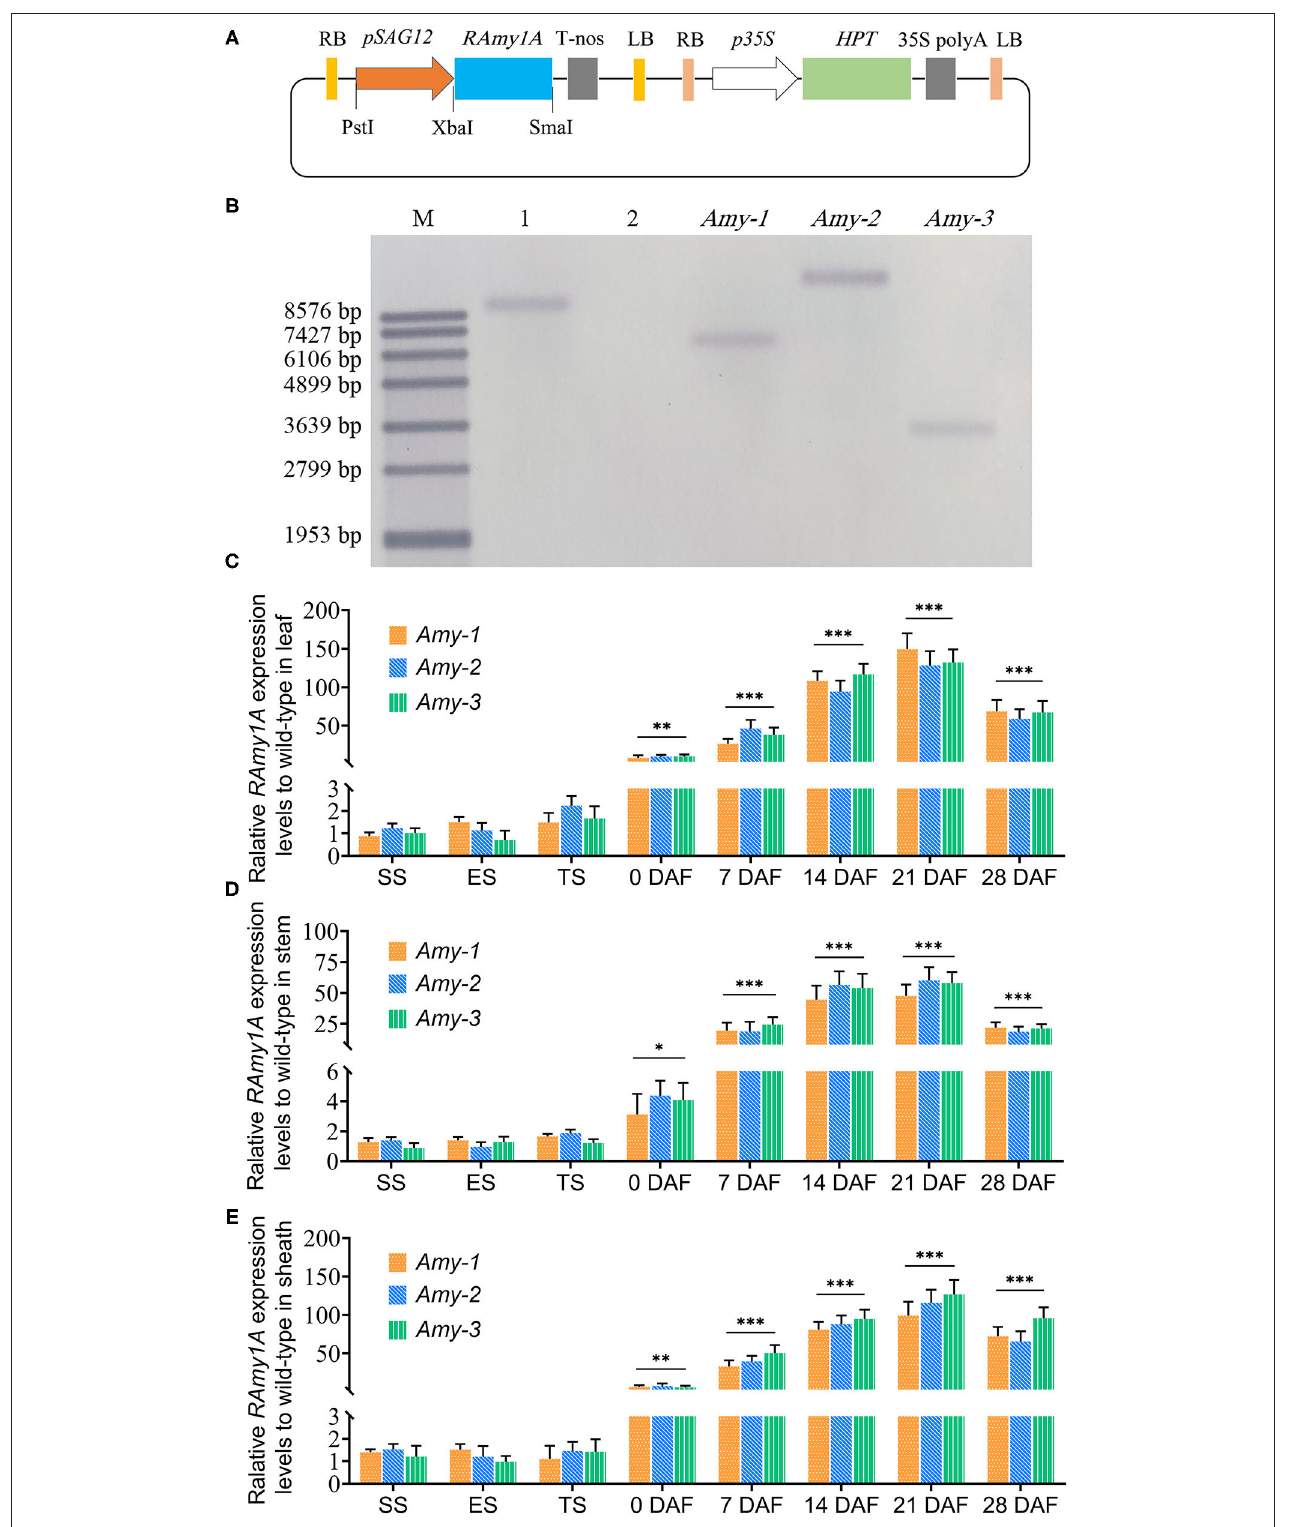
FIGURE 1 | Construction of the plant expression vector pSAG12::RAmy1A and molecular detection of transgenic rice lines. (A) Schematic diagram of the plasmid constructions. (B) Southern blot analysis of RAmy1A gene transgenic lines. M—DNA Molecular Weight Marker VII, DIG-labeled; 1—genomic DNA from plasmid as a